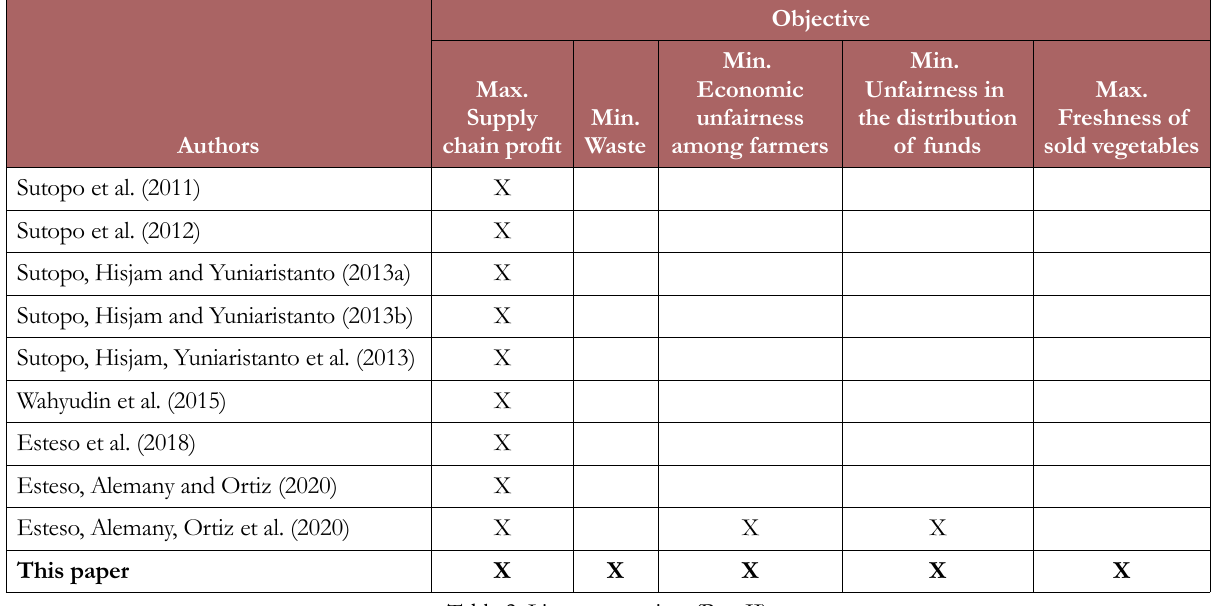
Table 2. Literature review (Part II)